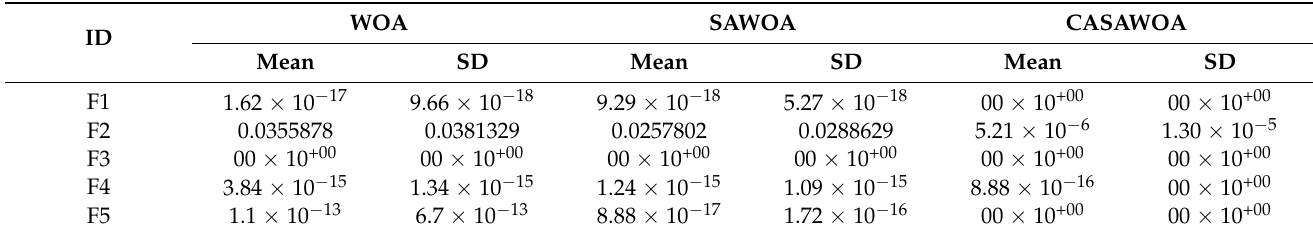
13 of 22 30 D = . Figure 4 shows the details of convergence speed